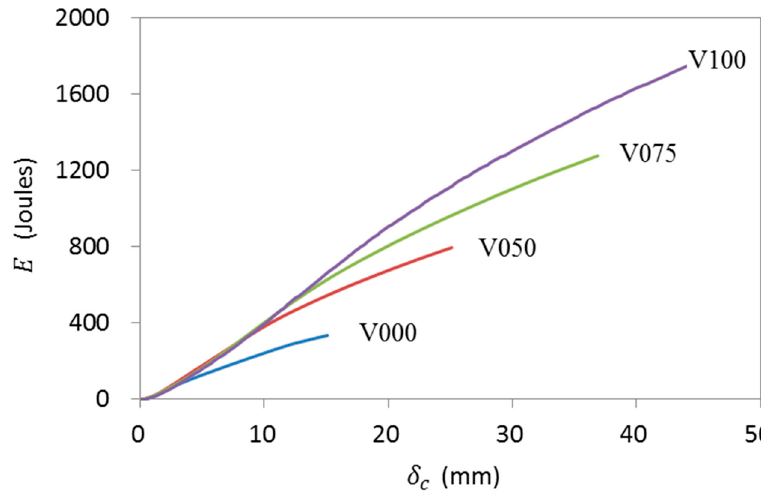
Figure 11. Typical energy absorption and displacement curves of the anchors in the plain concrete and SFRC .